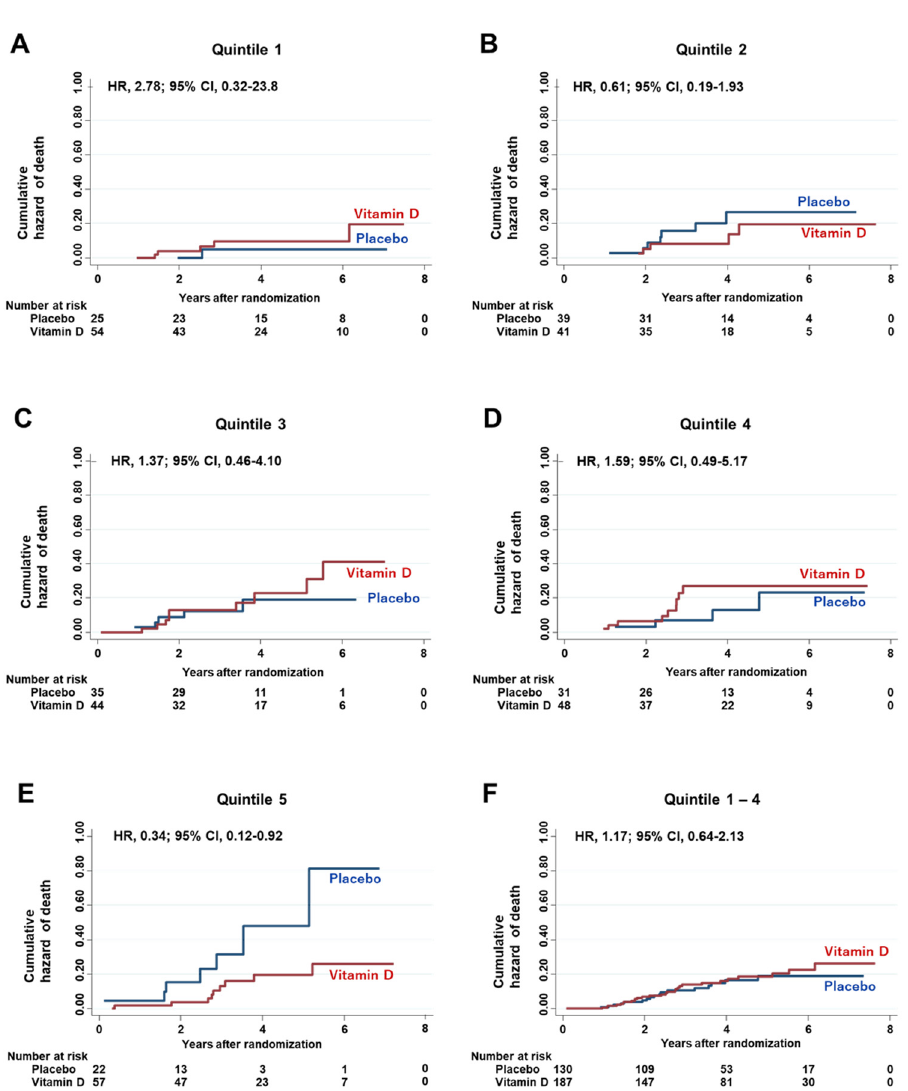
Figure 4. Cumulative hazard curves for death . Nelson–Aalen cumulative hazard curves ( A ) for death in the subgroup of 1st quintile of serum PD-L1 levels (Quintile 1), ( B ) for death in the subgroup of 2nd quintile of serum PD-L1 levels (Quintile 2), ( C ) for death in the subgroup of 3rd quintile of serum PD-L1 levels (Quintile 3), ( D ) for death in the subgroup of 4th quintile of serum PD-L1 levels (Quintile 4), ( E ) for death in the subgroup of 5th quintile of serum PD-L1 levels (Quintile 5), ( F ) for death in the subgroup of the sum of Quintile 1 to Quintile 4 serum PD-L1 levels. HR = Hazard ratio; CI = Confidence interval.